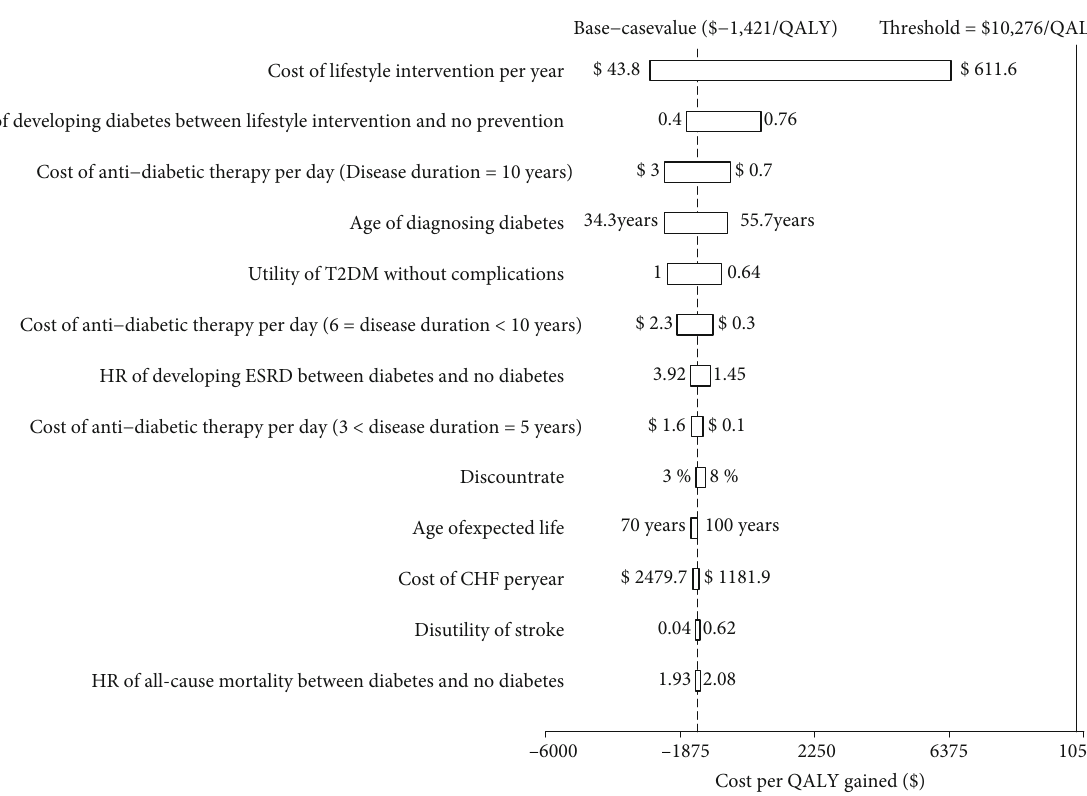
Figure 2: Tornado diagram representing the cost-e ff ectiveness in one-way sensitivity analysis for lifestyle interventions versus no prevention. The width of the bars represents the range of the results when the variables were